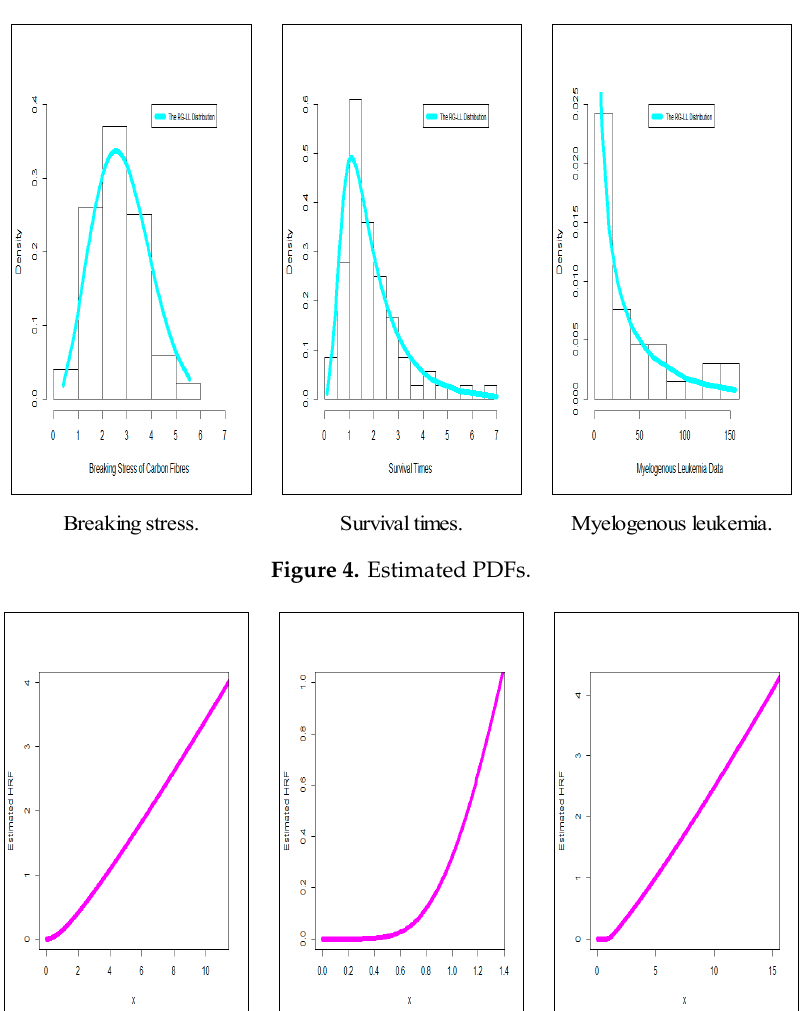
Figure 3. Estimated cumulative distribution functions (CDFs).